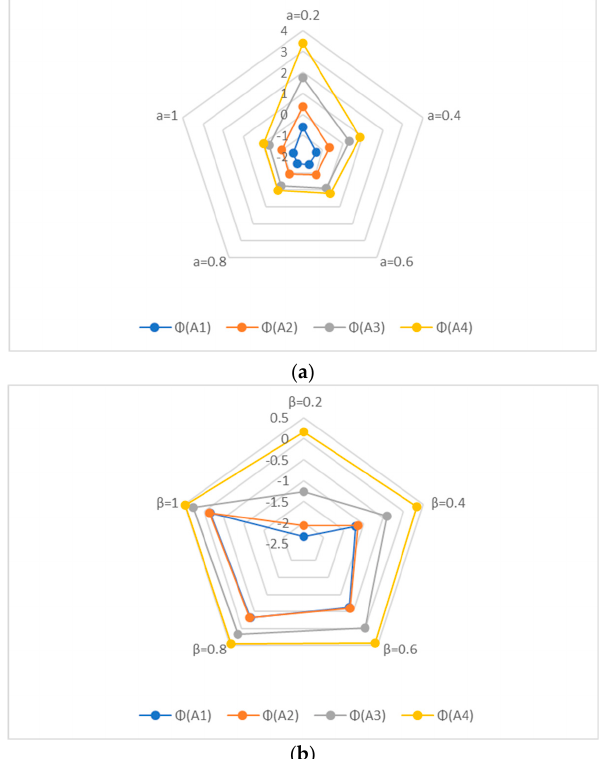
Figure 2. In fl uence of di ff erent values of 𝛼 and 𝛽 on pharmaceutical e-commerce platform rank- ing. ( a ) In fl uence of di ff erent values of 𝛼 on pharmaceutical e-commerce platform ranking. ( b ) In- fl uence of di ff erent values of 𝛽 on pharmaceutical e-commerce platform ranking. It can be clearly seen from Figures 1 and 2 that: